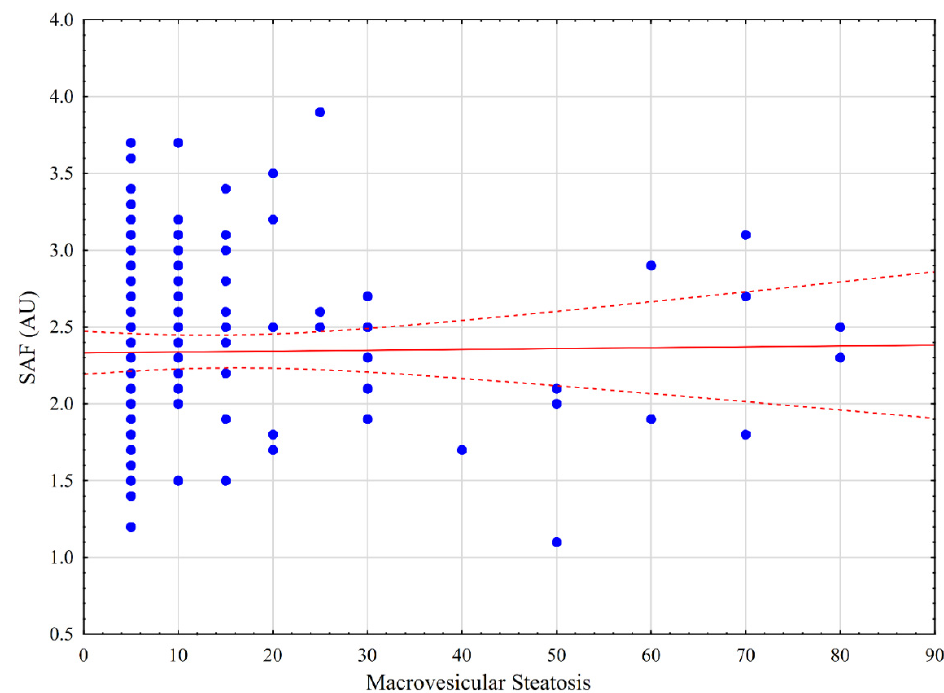
Figure 3. Correlation between skin autofluorescence (SAF) and degree of liver steatosis. ROC analysis for SAF revealed the optimal cutoff point of 2.4 AU as an independent predictor for macrovesicular steatosis ≥ 10% with an AUC of 0.629 (95% CI 0.538–0.721, p = 0.006), 59.9% sensitivity, 62.4% specificity, and positive (PPV) and negative (NPV) predictive values of 45.7% and 74.1%, respectively (Figure 4). In the group of patients with SAF ≥ 2.4 AU, 32 (45.7%) patients had macrovesicular steatosis in ≥ 10% of the liver as compared to 22 (25.9%) patients in the SAF < 2.4 AU group ( p = 0.010).